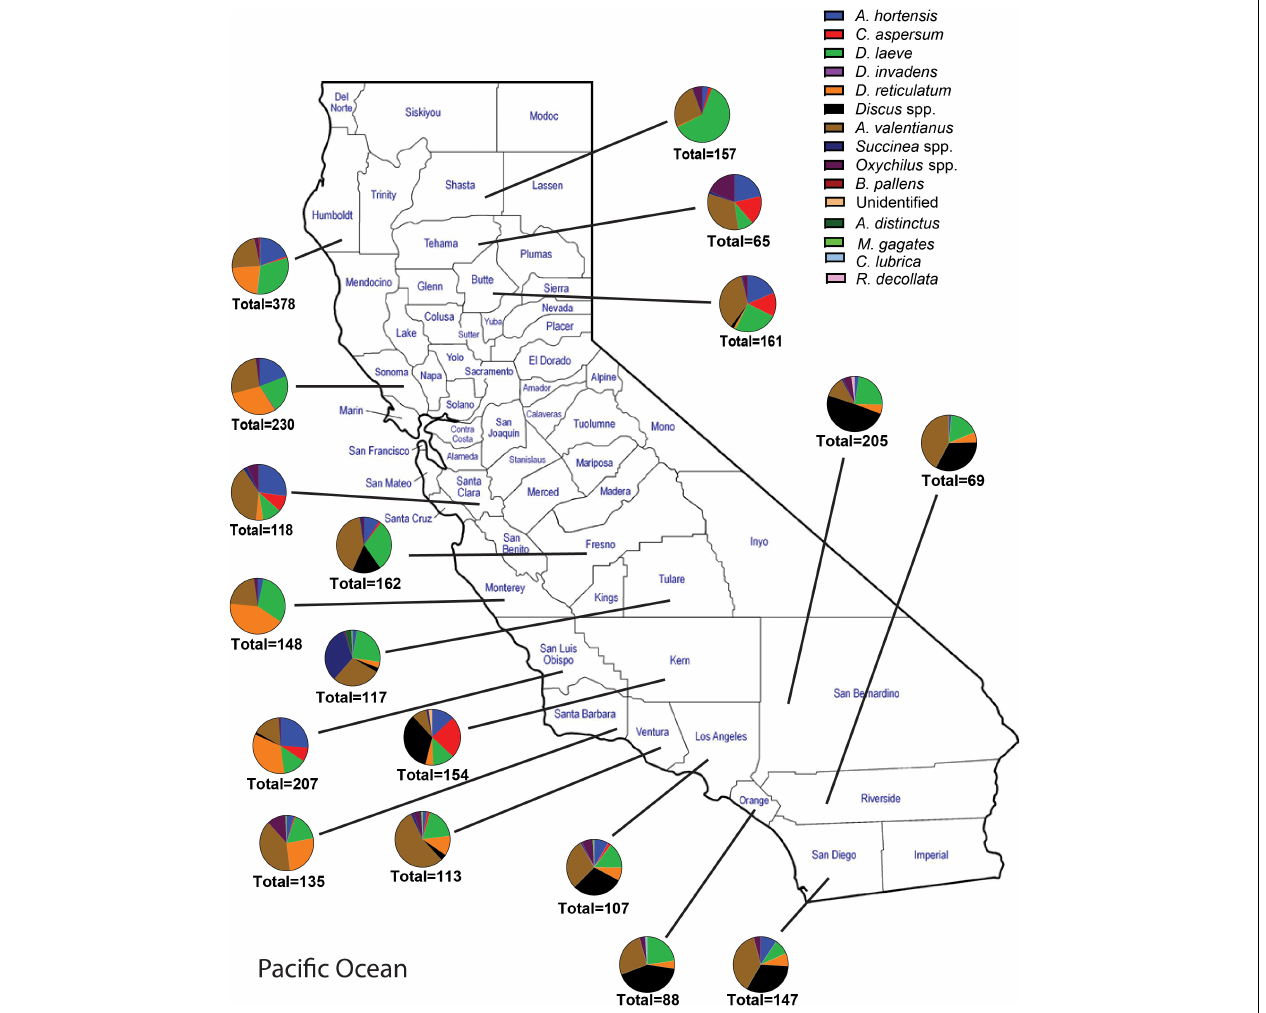
FIGURE 2 | Abundance and species richness of terrestrial gastropods collected in each California county surveyed between 2018 and 2021. Surveys were performed during late fall or winter. Survey methods included 1 human hour searching for gastropods throughout each nursery. Collected gastropods were sorted by species and were taken back to the laboratory for later verification of species